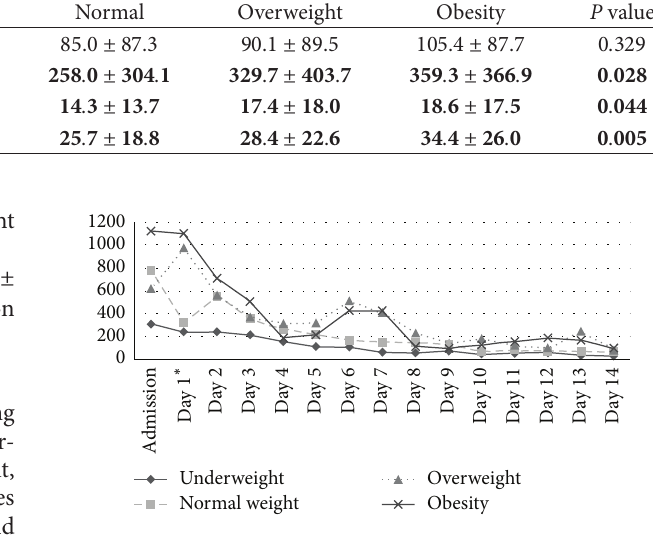
Figure 1: Mean IL-6 courses (pg/mL) evaluated from admission to day 14 according to the BMI groups. Significant differences (𝑃 < 0.05) are marked with an asterisk referring to the day of